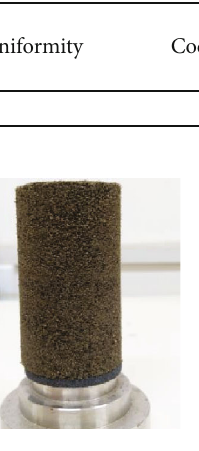
Figure 1: Complete preparation sample.